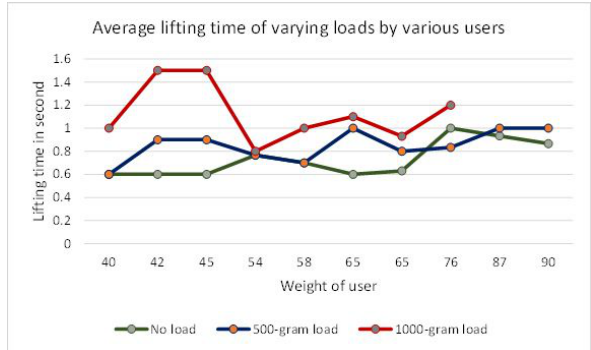
Figure 17: Graph of live load test results